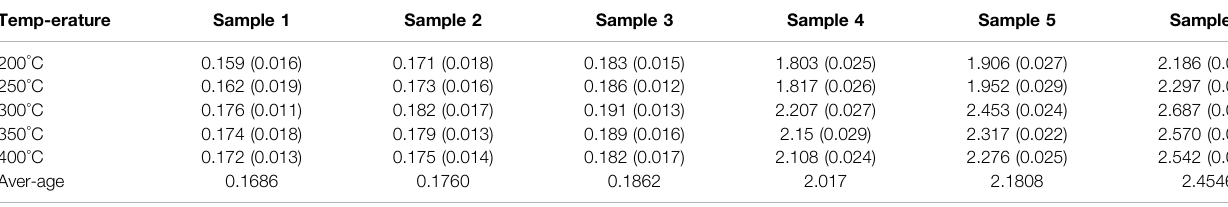
TABLE 6 | Thermal diffusivity (mm 2 /s) of different samples. Temp-erature